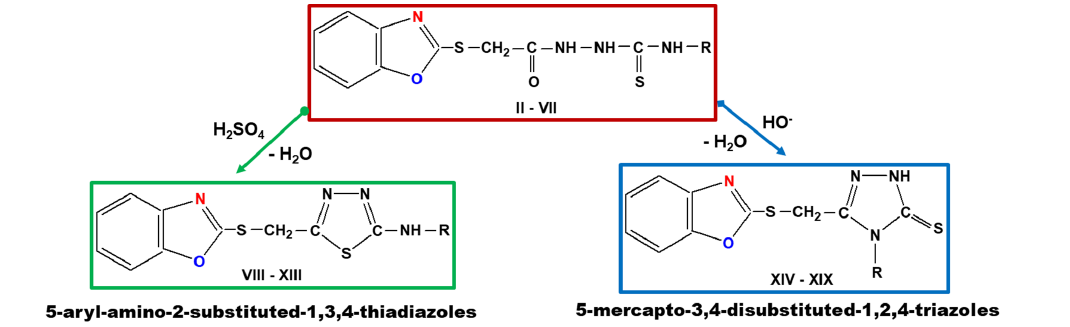
Figure 3. 1 H-NMR spectra of 1-(benzoxazole-2 (cid:48) -yl-mercapto-acetyl)-4-(p-methoxyphenyl)-thiosemicarbazide (compound IV).